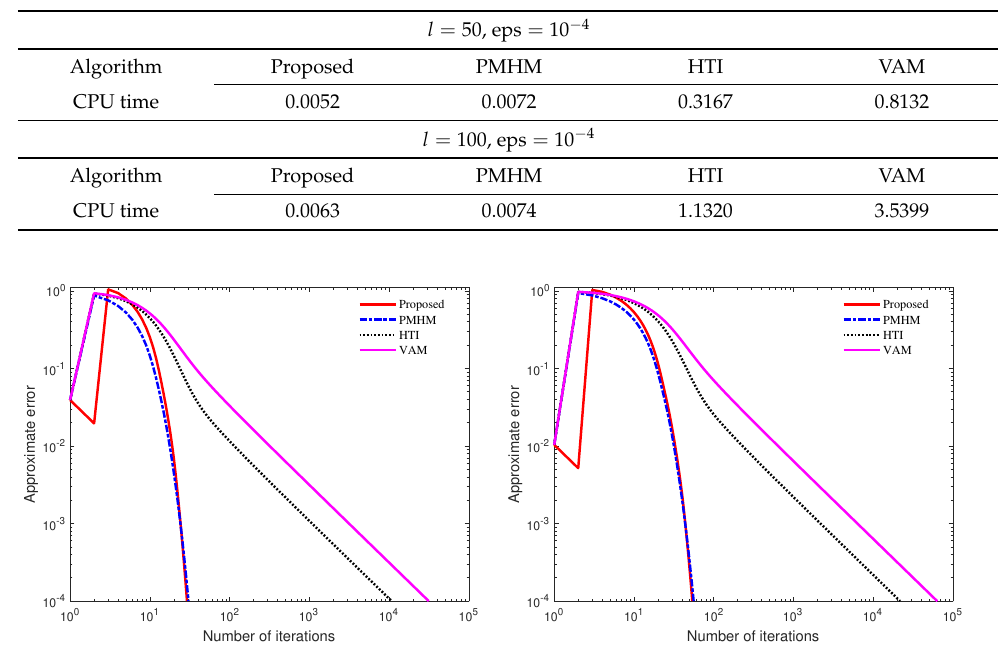
Figure 4. The progression of the number of iterations for the proposed methods and the PMHM, HTI, and VAM in solving the problem (12) with l = 50 and l = 100,